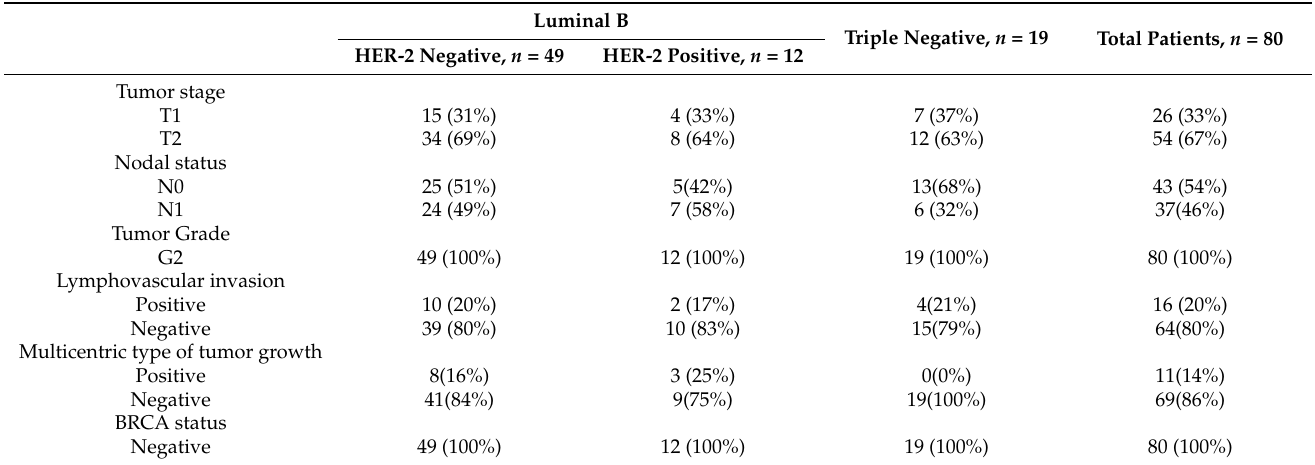
Table 7. Clinical characteristics of BCPs.